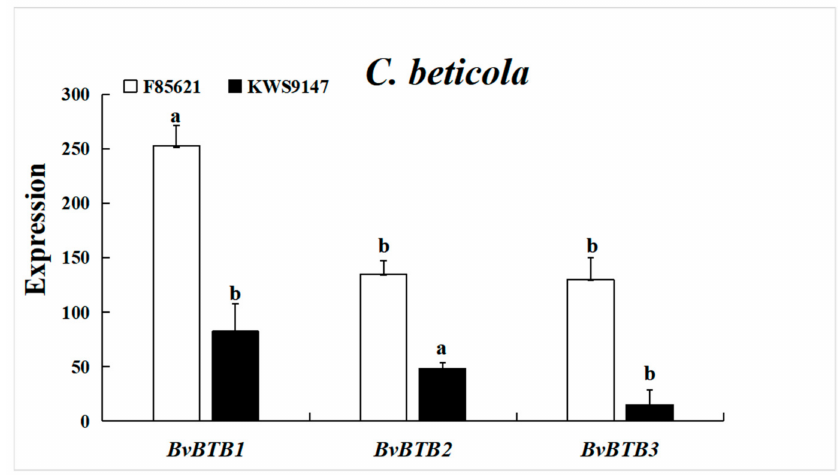
Figure 3. Expression of BvBTB genes in different transcriptomes in the materials. The transcriptomic data from sugar beet resistant material ‘F85621’and susceptible material ‘KWS9147’ in response to C. beticola infection for 12 h. X-axial represents the gene names in the sugar beet transcriptomic data, while Y-axial represents BvBTB gene expression in the sugar beet transcriptomic data. The experiment was performed on three biological replicates, each with three technical replicates, and was statistically analyzed using variance analysis ( p < 0.05), different letters represent significant levels of p < 0.05. 3.5. Agarose Gel Electrophoresis of PCR Amplification of BvBTB1, BvBTB2, and BvBTB3